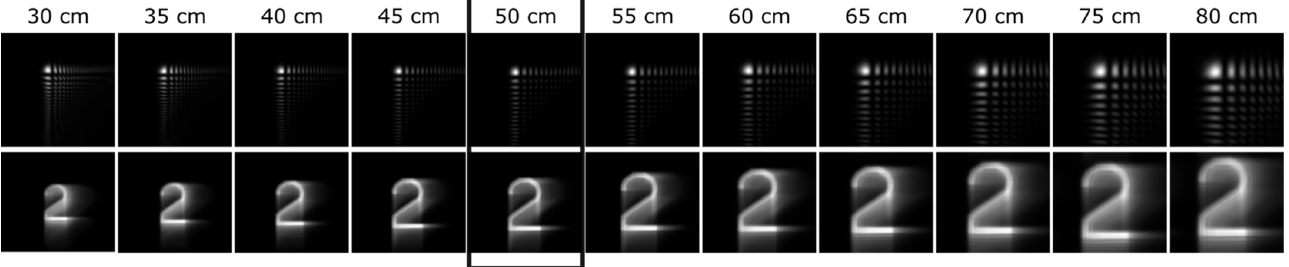
Figure 5. Kurtosis measure of the PSFs of the combined APM + FL imaging system along the z’- image plane range.